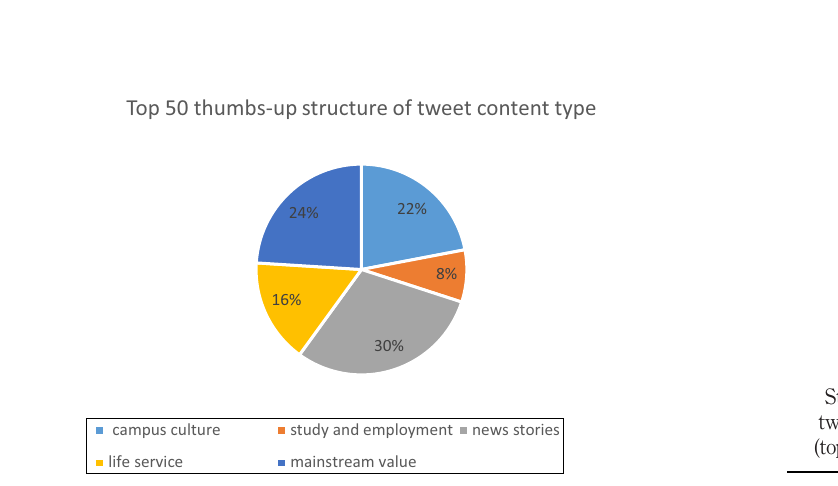
Figure 1. Average read